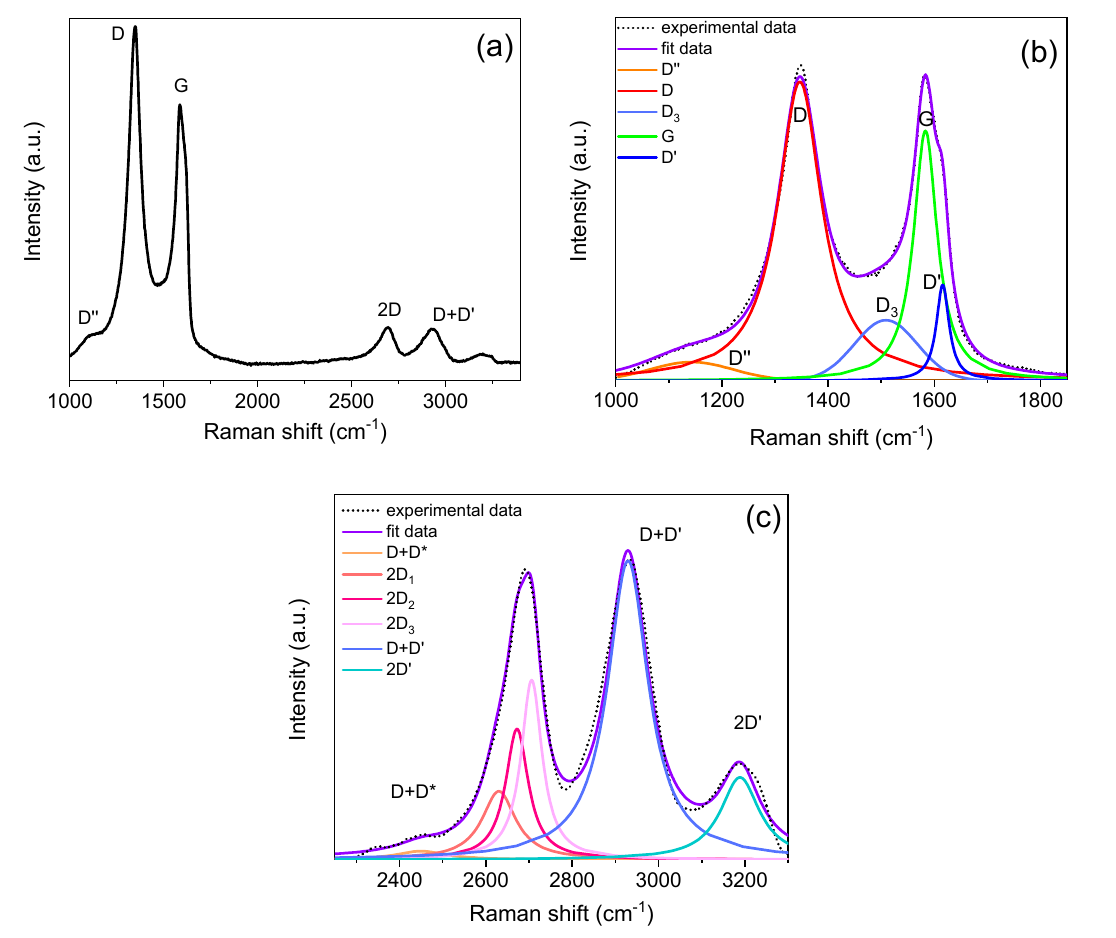
Figure 2. ( a ) Raman spectrum acquired on the as-synthesized graphene nanosheets; ( b ) Deconvolution of the first-order Raman spectrum using five functions (D‘’, D, D 3 , G and D’ bands); ( c ) Deconvolution of the second-order Raman spectrum using six functions (D + D*, 2D 1 , 2D 2 , 2D 3 , D + D’ and 2D’ bands).